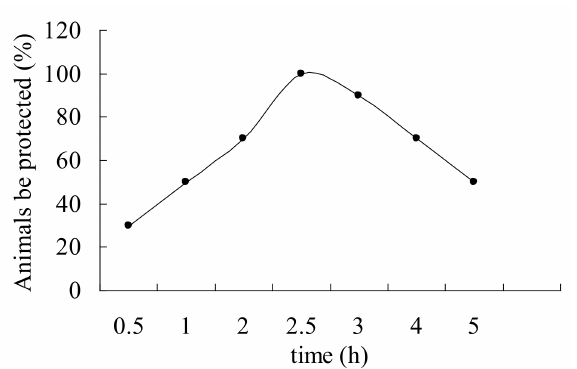
Figure 2. Time-course of compound 4g (50 mg/kg) in the maximal electroshock seizure test (i.p.). The data illustrates % animal protected relative to animal tested (10 for each point) at various times after injection.